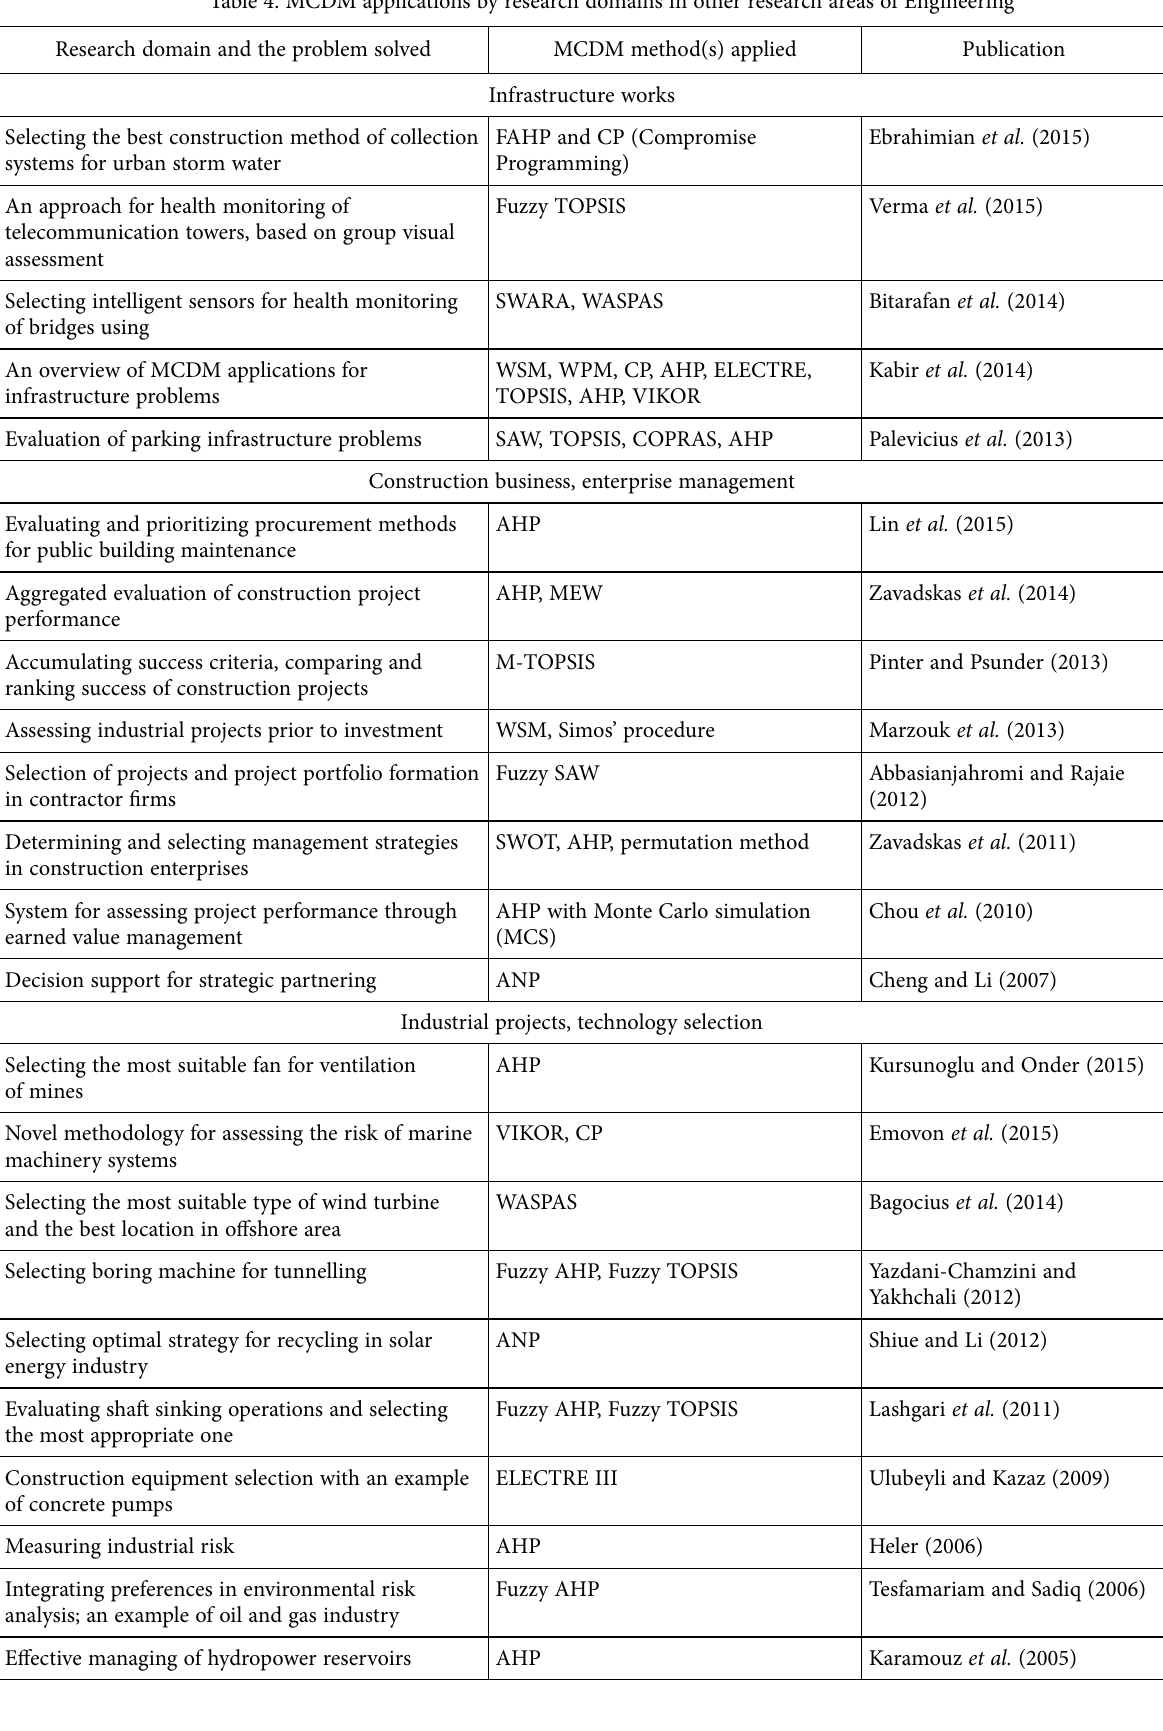
Table 4. MCDM applications by research domains in other research areas of